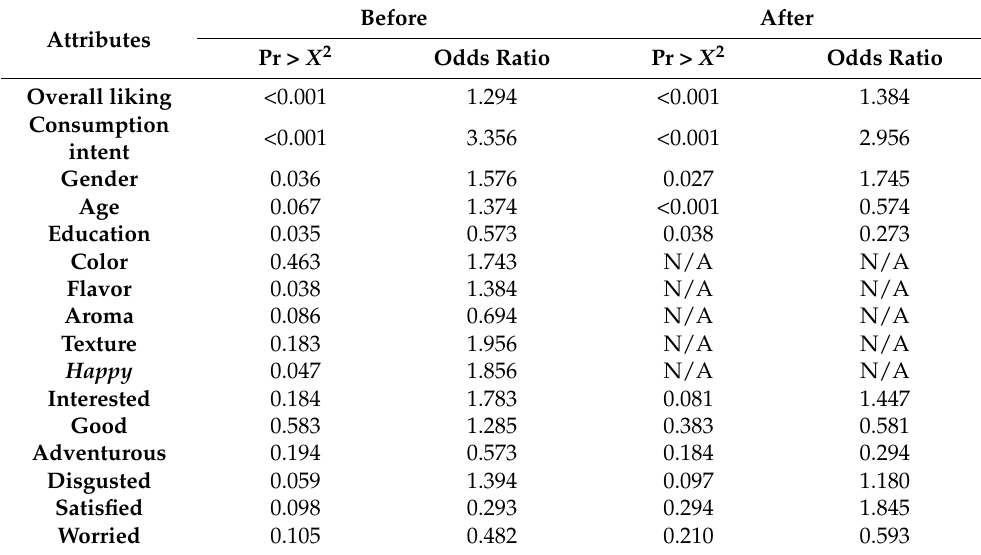
Table 7. Odds ratio for predicting purchase intent before and after beneficial